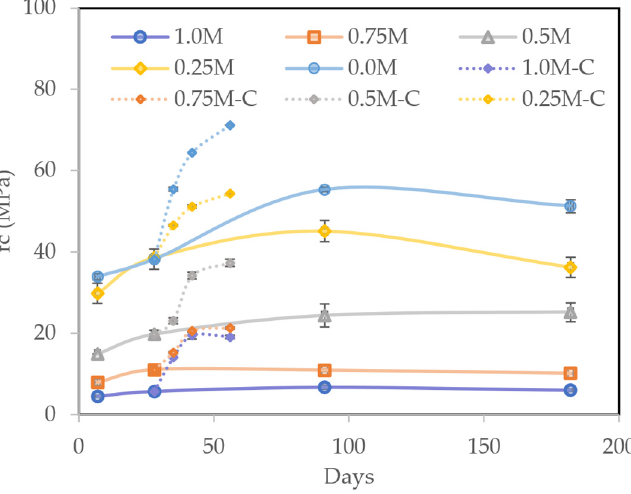
Figure 9. Compressive strength of uncarbonated and carbonated mortars with CAA design.